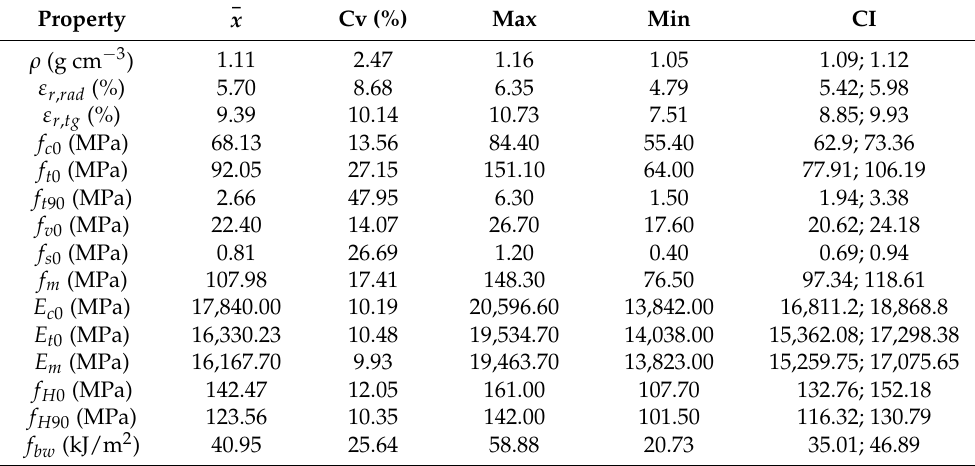
Table 2. Results of physical and mechanical properties tests for Tabebuia sp. wood from harvesting regions